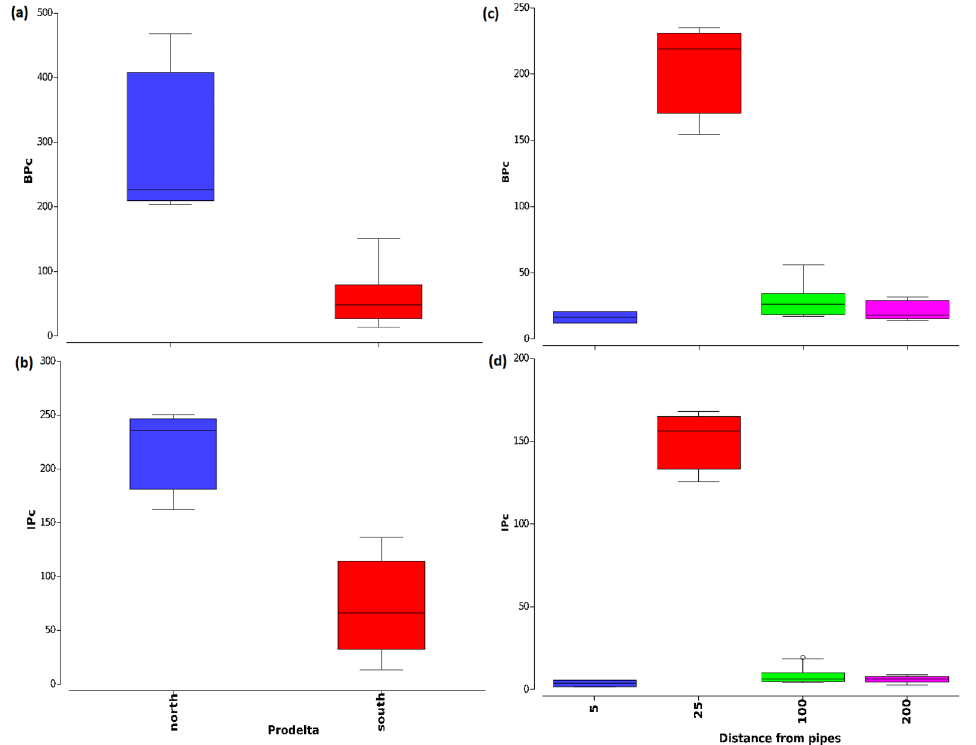
Figure 4. Boxplots showing the variability of bioturbation potential (BP c ) and irrigation potential (IP c ) of community at north and south for Po River coastal area ( a , b ), and at increasing distance from pipelines (<5, 25, 100, and >200 m) in the Gulf of Trieste ( c , d ).